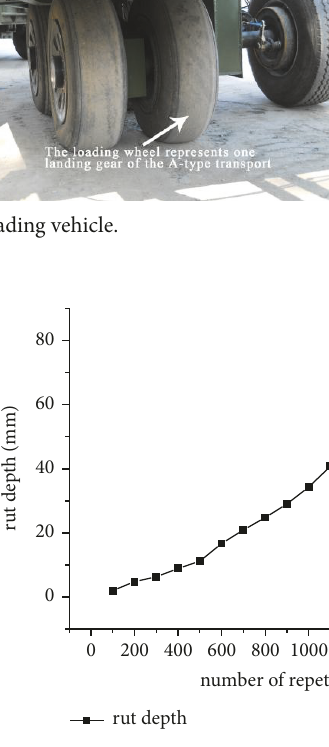
Figure 11: Variation of rut depth with increasing loading